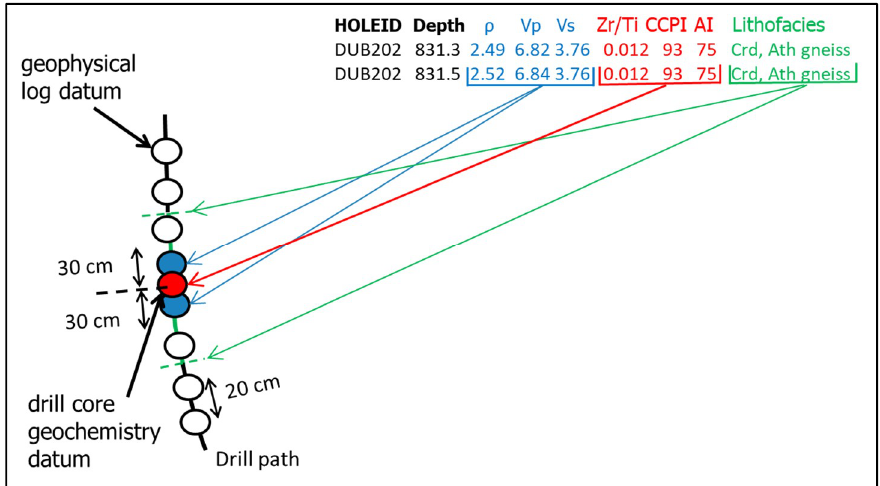
Figure 2. Schematic diagram showing the co-registration of the drill hole wireline log, lithogechemical, and lithofacies log data.